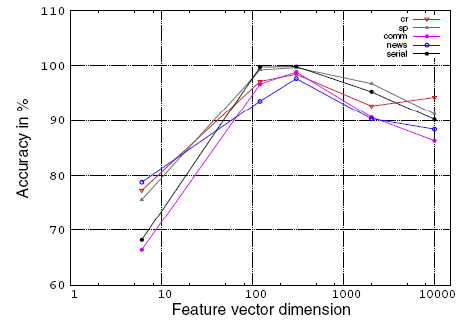
Fig. 5. BICC performance for various feature dimension features, color histogram features 24 and other existing features that are potentially useful for